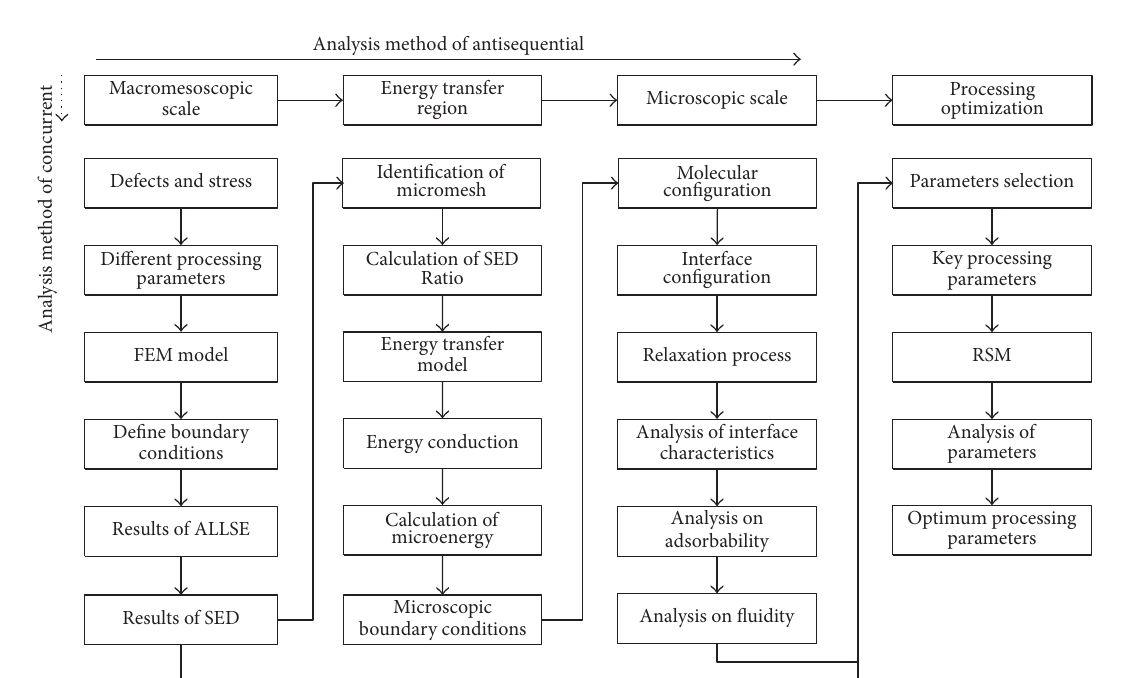
Figure 3: Antisequential hierarchical multiscale collaborative optimization method of processing parameters.